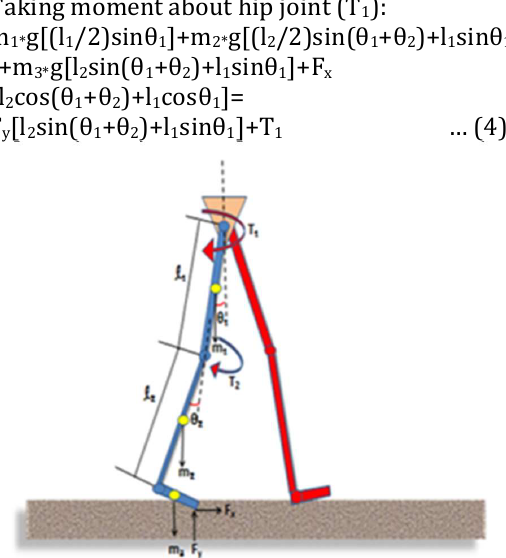
Fig. 4: 2 nd double support phase.